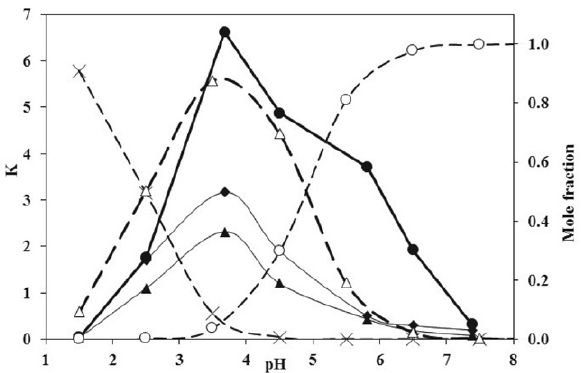
Figure 2. Partition coefficients (K) of PABA between water and dif- ferent ionic liquids: (  ), [C 8 mim][PF 6 ]; (  ), [C 4 mim][PF 6 ]; (  ) [C 8 mim][BF 4 ]. Mole fraction of various chemical forms of PABA at different pH values: (×), cationic form (PA + ); (∆), neutral form (PA); (  ), anionic form (PA −